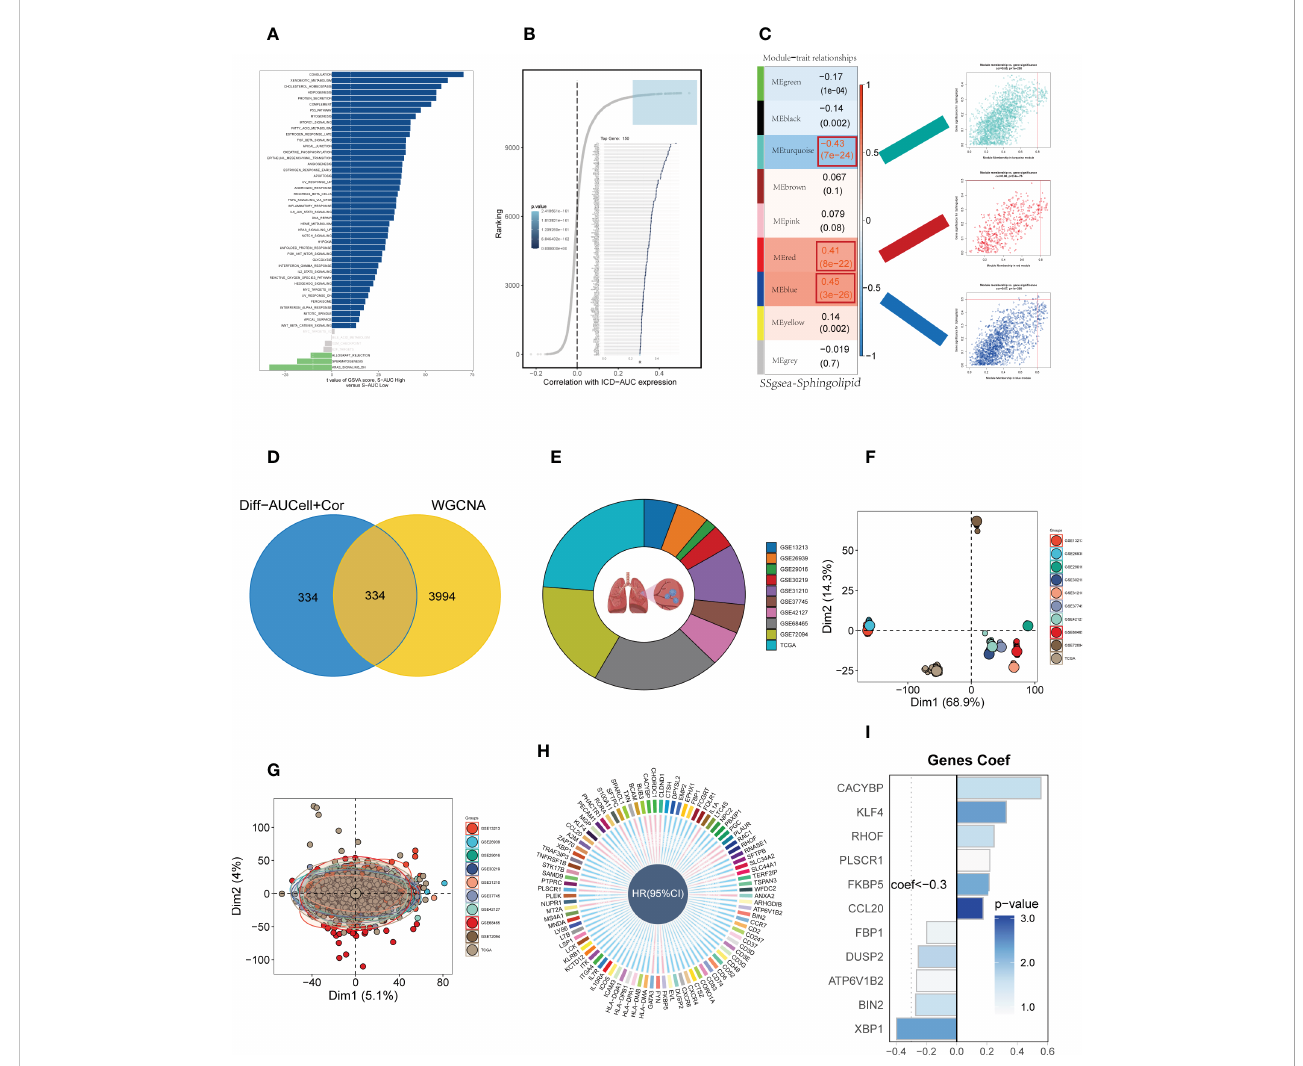
FIGURE 3 Construction and validation of SM-related prognostic model. (A) GSVA showed the enrichment of hallmark gene sets in different SM AUCell groups. (B) Correlation analysis between SM-AUCell score and genes. (C) WGCNA analysis searched for the modules most associated with SM activity. (D) Venn plots identi fi ed the genes most associated with SM activity. (E The sources of samples and the proportion of sample size in 10 datasets were analyzed. (F, G) PCA plots before and after removal of batch effects for 10 datasets. (H) Genes signi fi cantly associated with prognosis after univariate regression. (I) Model genes and coef fi cients identi fi ed by lasso regression and multivariate